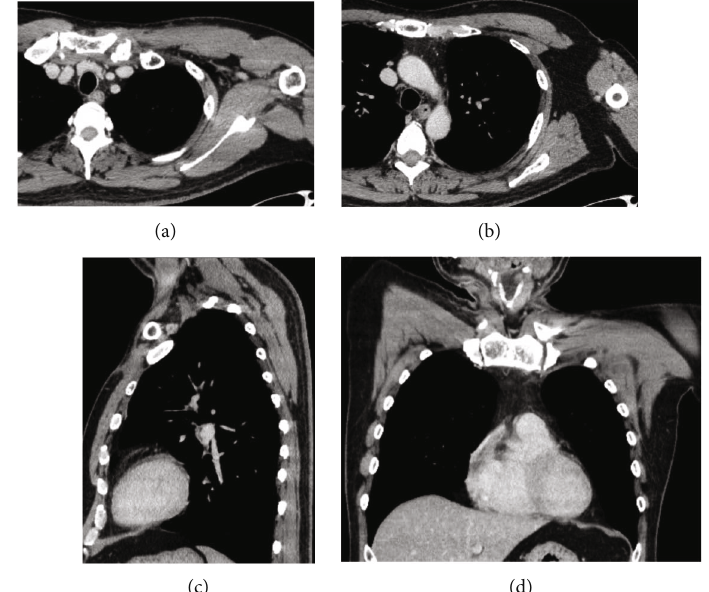
Figure 3: Contrast-enhanced chest computed tomography images in axial (a, b), sagittal (c), and coronal planes (d) four months after